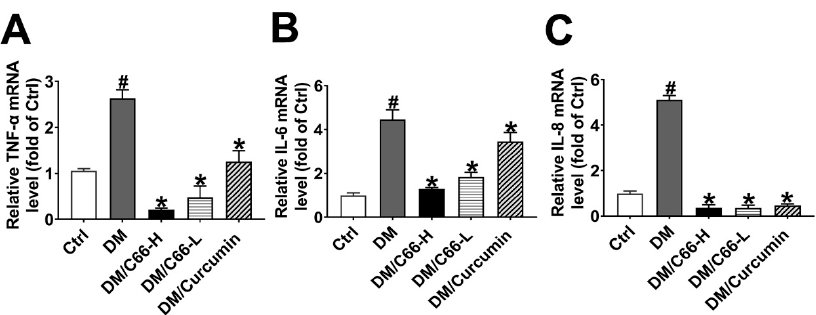
Figure 7. C66 significantly downregulated pro-inflammatory cytokines. Real-time quantitative RT- PCR analysis of mRNA for TNF- α ( A ), IL-6 ( B ), and IL-8 ( C ) in the 14-day wounds of different groups. The expression levels of pro-inflammatory cytokines were significantly downregulated in the C66 treatment group compared with the diabetes group ( p < 0.05). * p < 0.05 compared to the diabetes group value, # p < 0.05 compared to the control